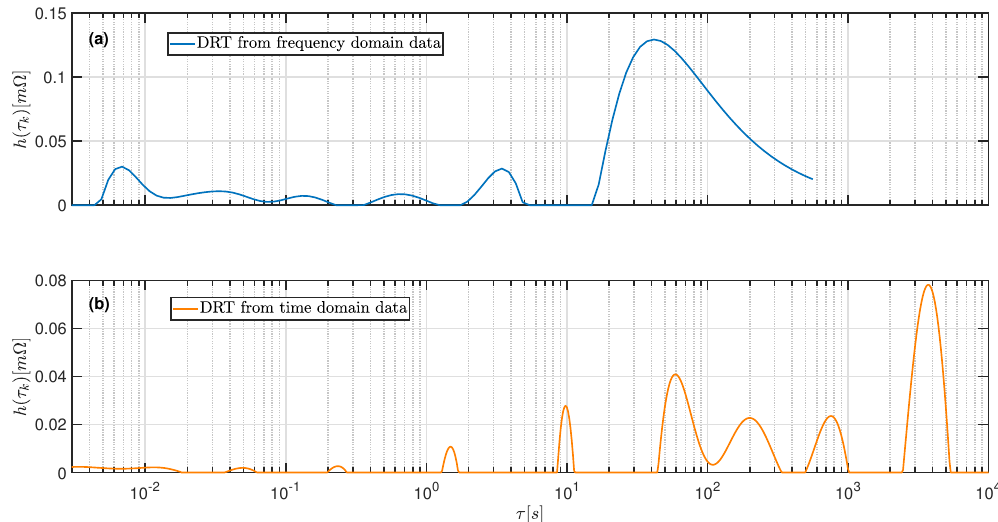
Figure 6. DRT derived from frequency domain data ( a ) and from time domain data ( b ).